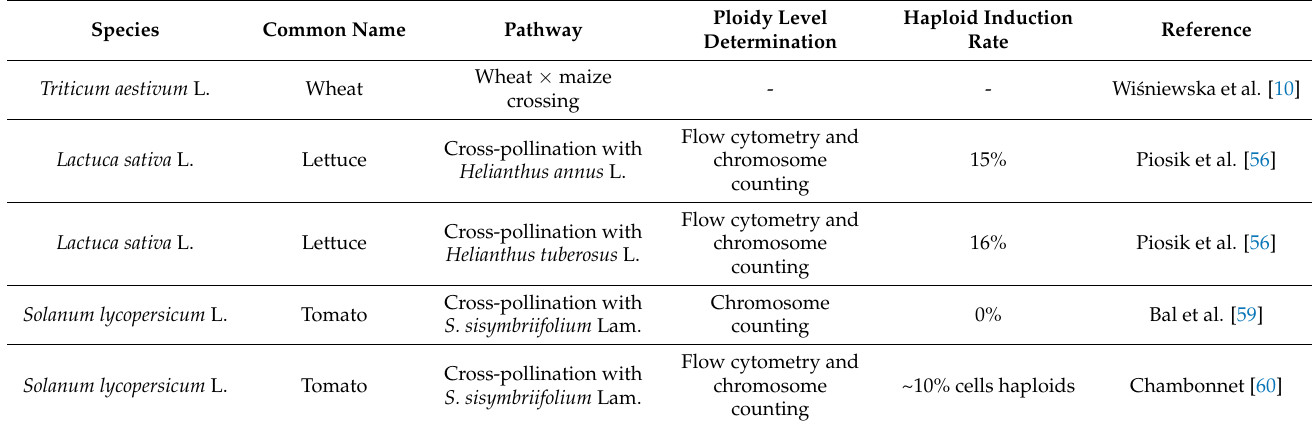
Table 4. Summary of haploid induction methodologies by wide hybridization.